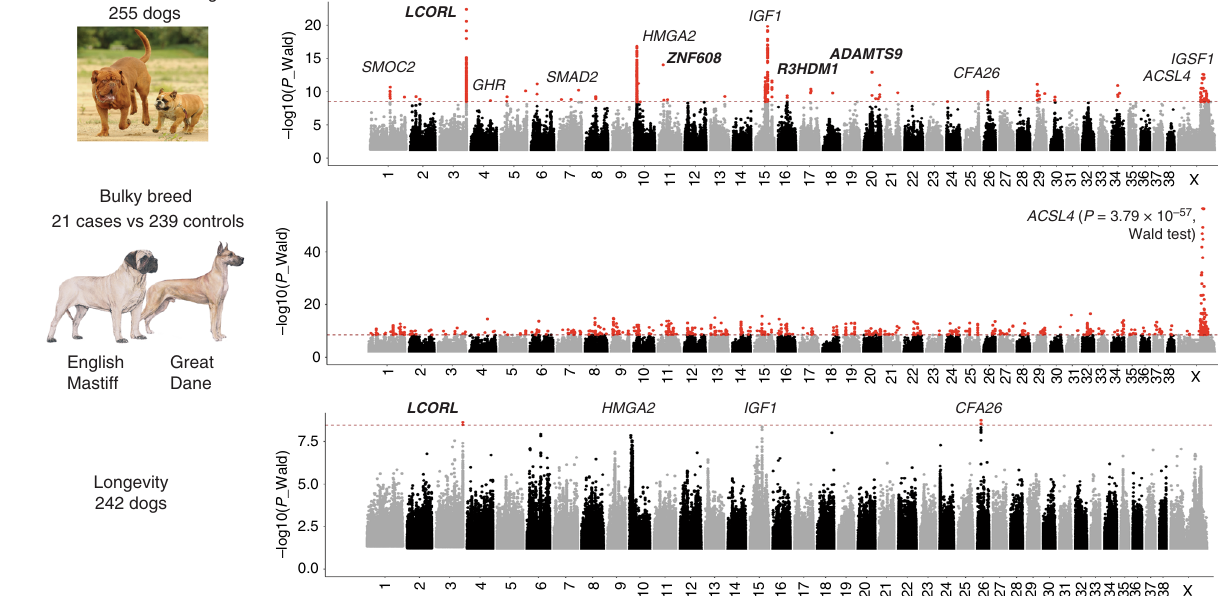
Fig. 1 GWAS results for morphological traits in dogs using the canine 722 genome catalog. Manhattan plots showing statistical signi fi cance ( − log10 scale) for the 30,000 most associated biallelic variants for each canine autosome, and all variants for the X chromosome ( X -axis). a Validation of this WGS- GWAS approach using known examples in dogs: presence or absence of moustache and eyebrows, length of fur, and height as a multigenic trait. b Associations identi fi ed using body mass including the bulky phenotype and life span. The red line represents the Bonferroni corrected signi fi cance threshold ( − log 10 ( P ) ≃ 8.46) and variants passing this threshold are colored in red. Candidate genes identi fi ed in this study are in (SBH) 1,13,16,18 (Fig. 1a). The analysis for SBH highlighted growth factor 1 ( IGF1 ), and one locus on Canis lupus familiaris only genes/loci previously described in dogs such as the ligand- chromosome 26 (CFA26) 1,13,16,18 . Signals at three previously identi fi ed genes, insulin like growth factor 1 receptor (IGF1R), dependent nuclear receptor corepressor-like gene ( LCORL ), insulin like growth factor 2 mRNA binding protein 2 (IGF2BP2 ) Stanniocalcin 2 (STC2), growth hormone receptor ( GHR ), and immunoglobulin superfamily member 1 (IGSF1) were SMAD family member 2 (SMAD2) , high mobility group AT-hook observed but did not pass the Bonferroni threshold (Fig. 1a). 2 ( HMGA2 ), fi broblast growth factor 4 ( FGF4 ), insulin like